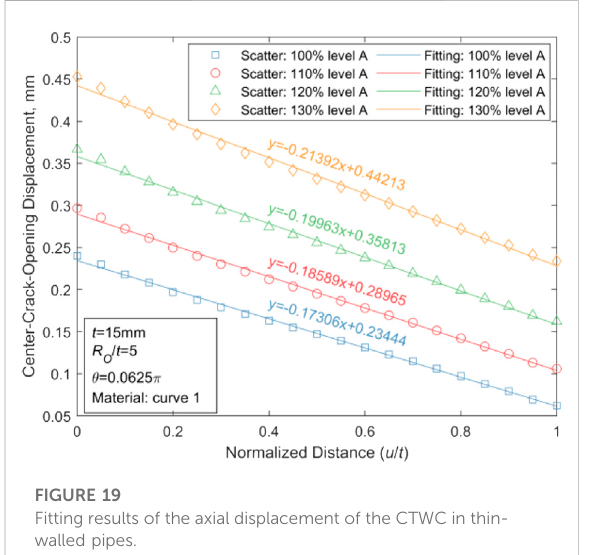
FIGURE 19 Fitting results of the axial displacement of the CTWC in thin- walled pipes.